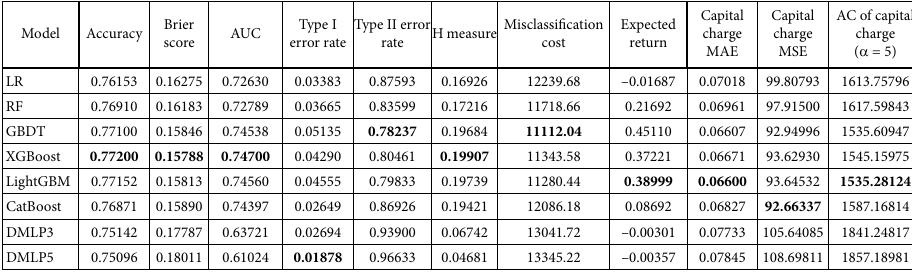
Table 4. Results of out-of-sample validation for Prosper dataset Model Accuracy Brier